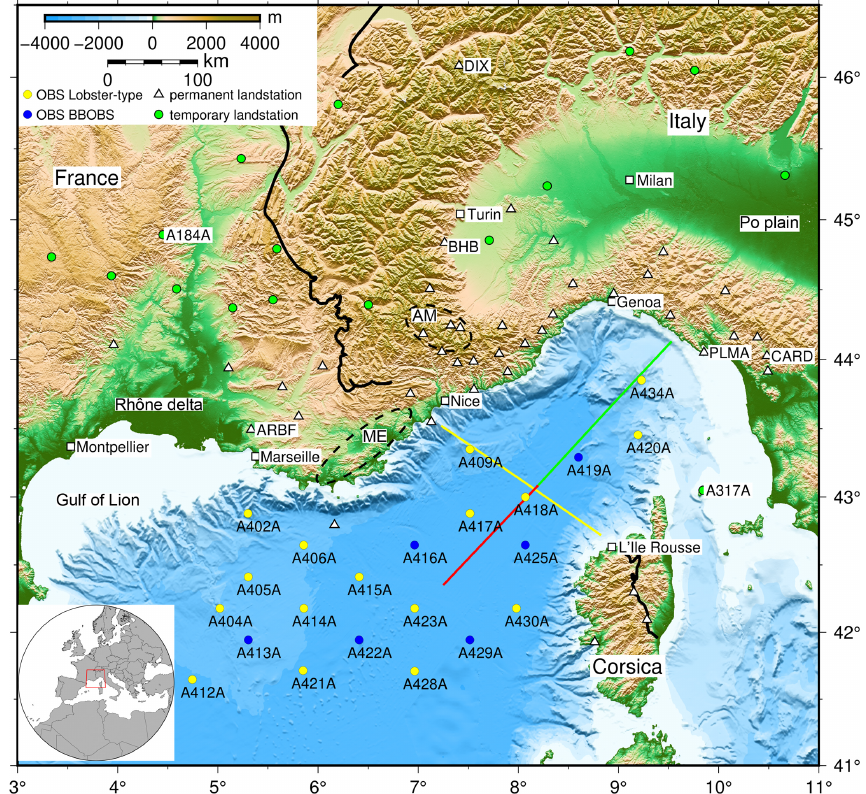
Figure 1. Map of the Ligurian Basin and adjacent Alpine region and the stations used for this study. OBS stations (network code: Z3) are shown as yellow (LOBSTER type) and blue (BBOBS) circles. Permanent land stations (network codes: CH, FR, GU, IV, and MN; see Table S1) are shown as white triangles. Temporary land stations from AlpArray (network code: Z3) are shown as green circles. Station names are given for the OBSs and land stations mentioned in the text or used in Fig. 3. White squares represent cities. The black line represents the Alpine front (Schmid et al., 2004), AM marks the Argentera Massif, and ME marks the Maures–Esterel Massif. The inlay map in the bottom left shows the location of the research area (red box). The red, green, and yellow lines show seismic refraction and reflection lines – red: Dannowski et al. (2020), green: Makris et al. (1999), yellow: LISA01, Contrucci et al. (2001). The topography is plotted based on a GMRT grid (Ryan et al.,